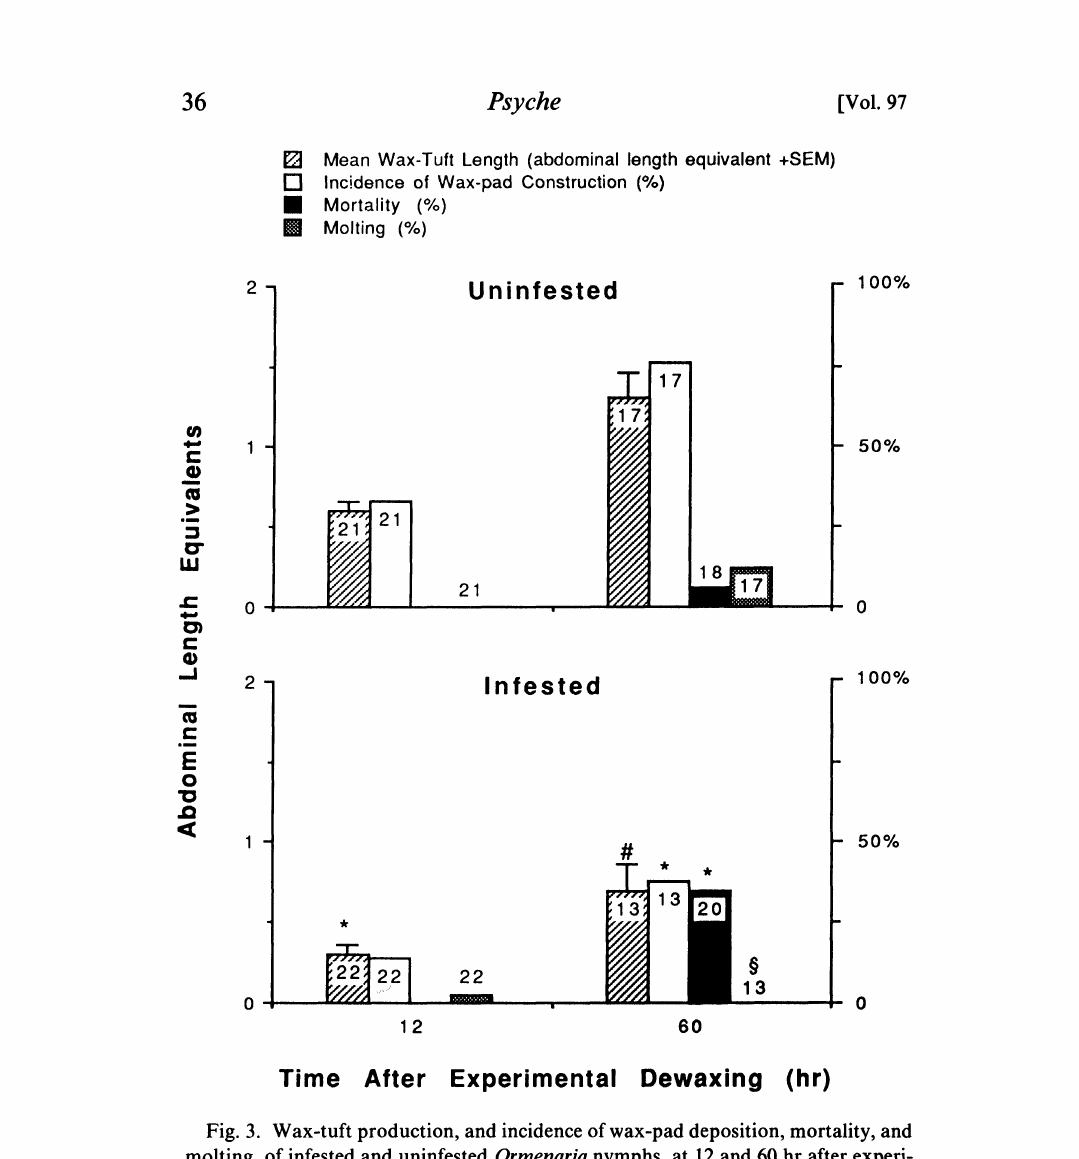
Fig. 3. Wax-tuft production, and incidence of wax-pad deposition, mortality, and molting, of infested and uninfested Ormenaria nymphs, at 12 and 60 hr after experi- mental dewaxing. Numbers within/atop bars give sample sizes. Symbols indicate level of statistical difference from uninfested category (* p < 0.01; p < 0.02; # p < 0.005). Details in